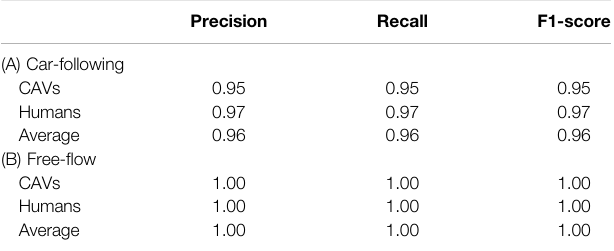
TABLE3| Classifyinghumans ’ andCAVs ’ brakingbehaviorunderdifferentdriving conditions using the ANN classi fi er.